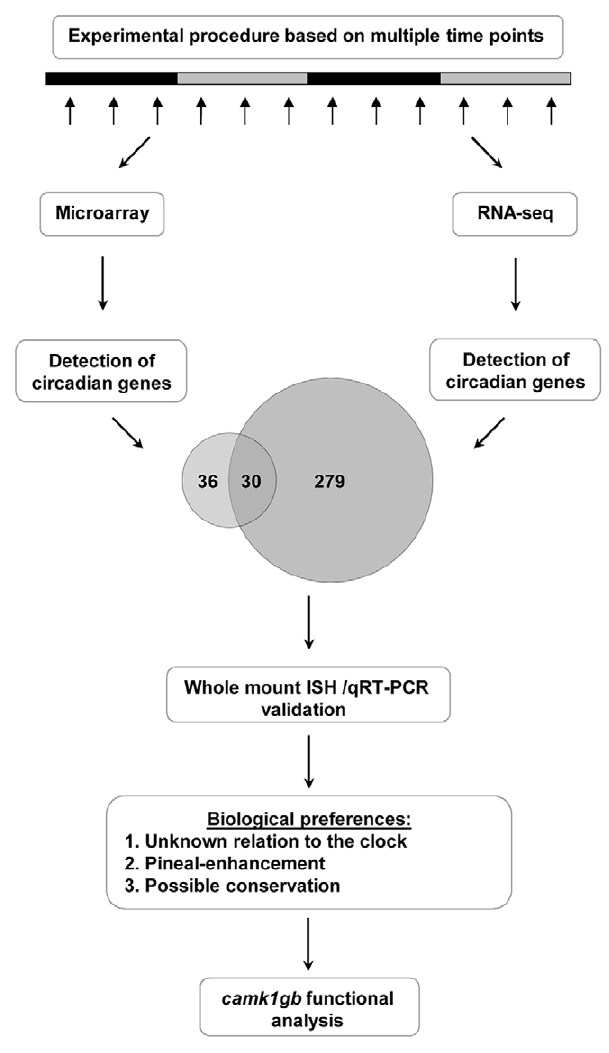
Figure 1. A step-by-step flow-chart of the systematic identifi- cation of pineal gland circadian genes. This procedure ultimately led to the detection of a new player, camk1gb , within the clock system.